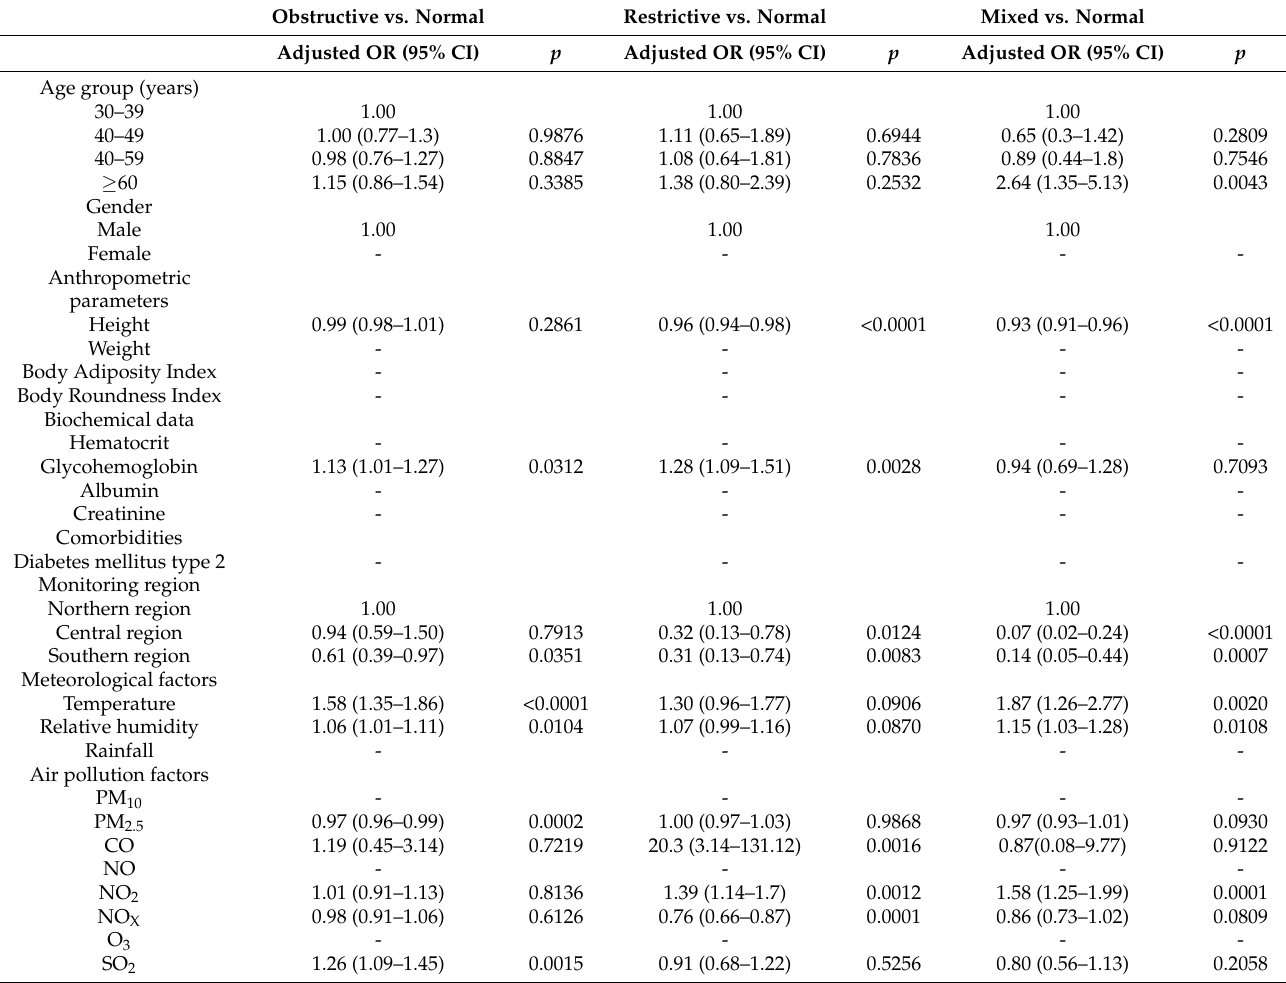
Table 2. Stepwise multinomial logistic regression